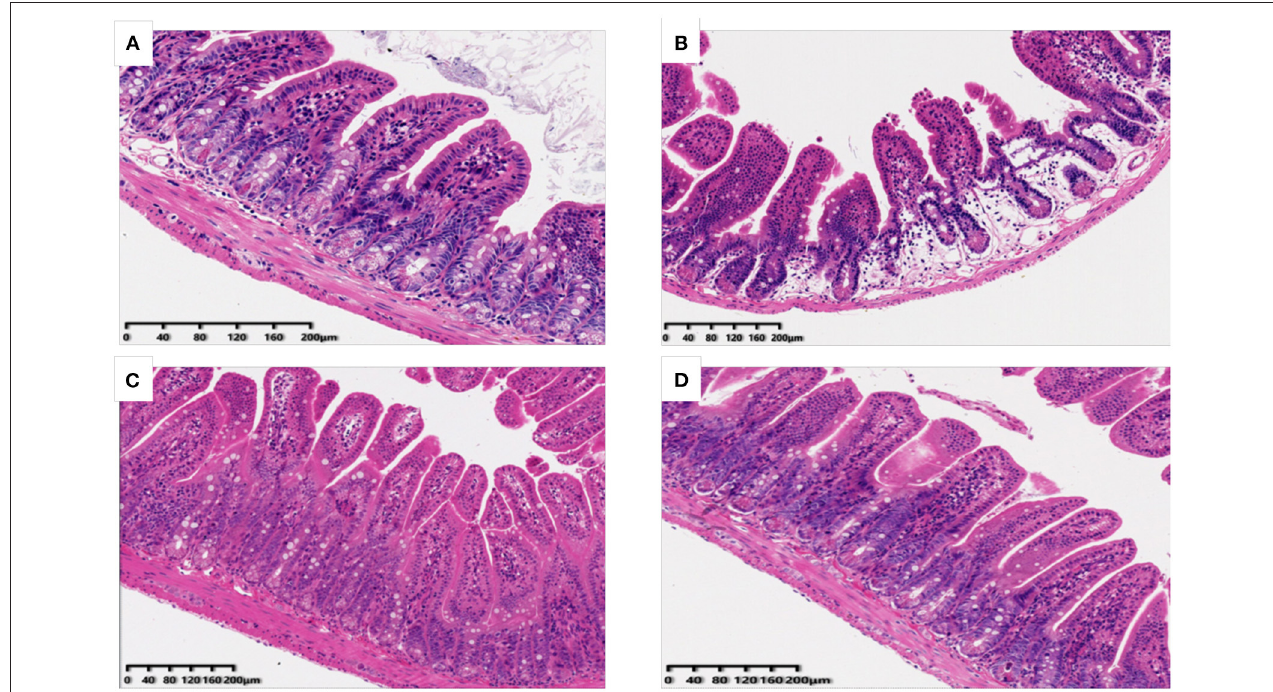
FIGURE 2 | Effects of OP on ileum histomorphology in oxidative injured mice [ (A) : Normal group; (B) : Cy-induced group; (C) : LP: Cy + 200 mg/kg OP; (D) : HP Cy + 400 mg/kg OP;